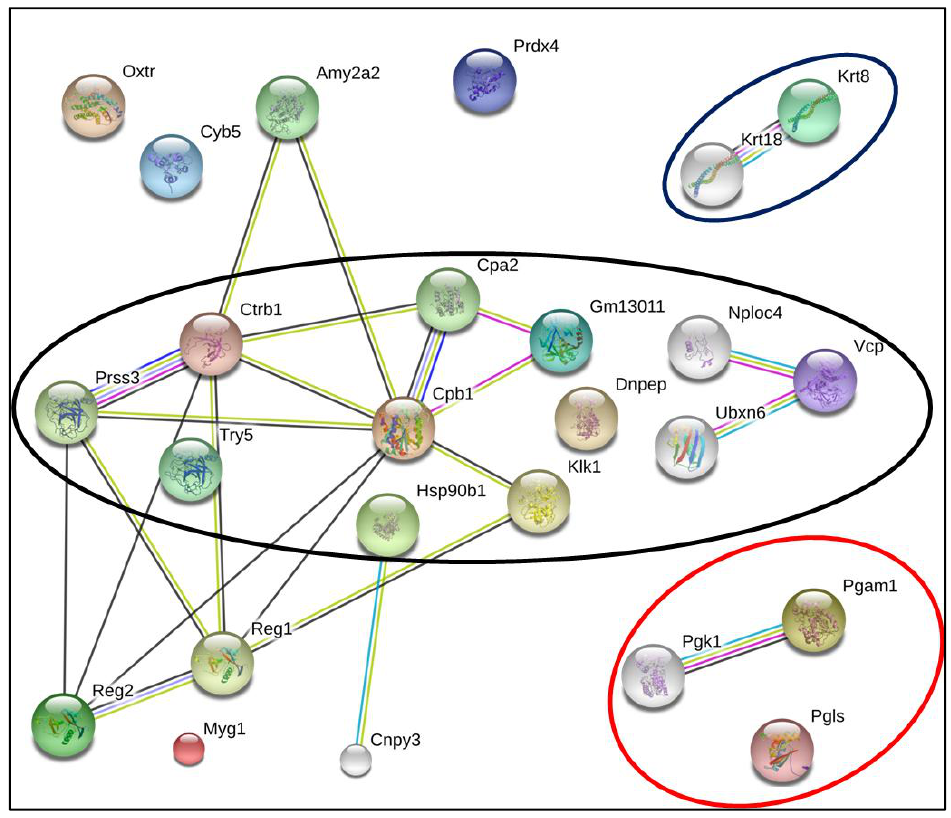
Figure 3. Bioinformatics analysis by STRING. The list of the identified proteins was subjected to STRING (v. 9.05) analysis to reveal functional interactions between the deregulated proteins. Each node represents a protein, and each edge represents an interaction. The original graphic output was modified to fit the proteins, according to their classification under the gene ontology descriptor “Biological Process”: proteolysis (confined within the red circle), glucose catabolic process (confined within the black circle) and tumor necrosis factor-mediated signaling pathway (confined within the blue circle) as revealed by the DAVID (v. 6.7) annotation